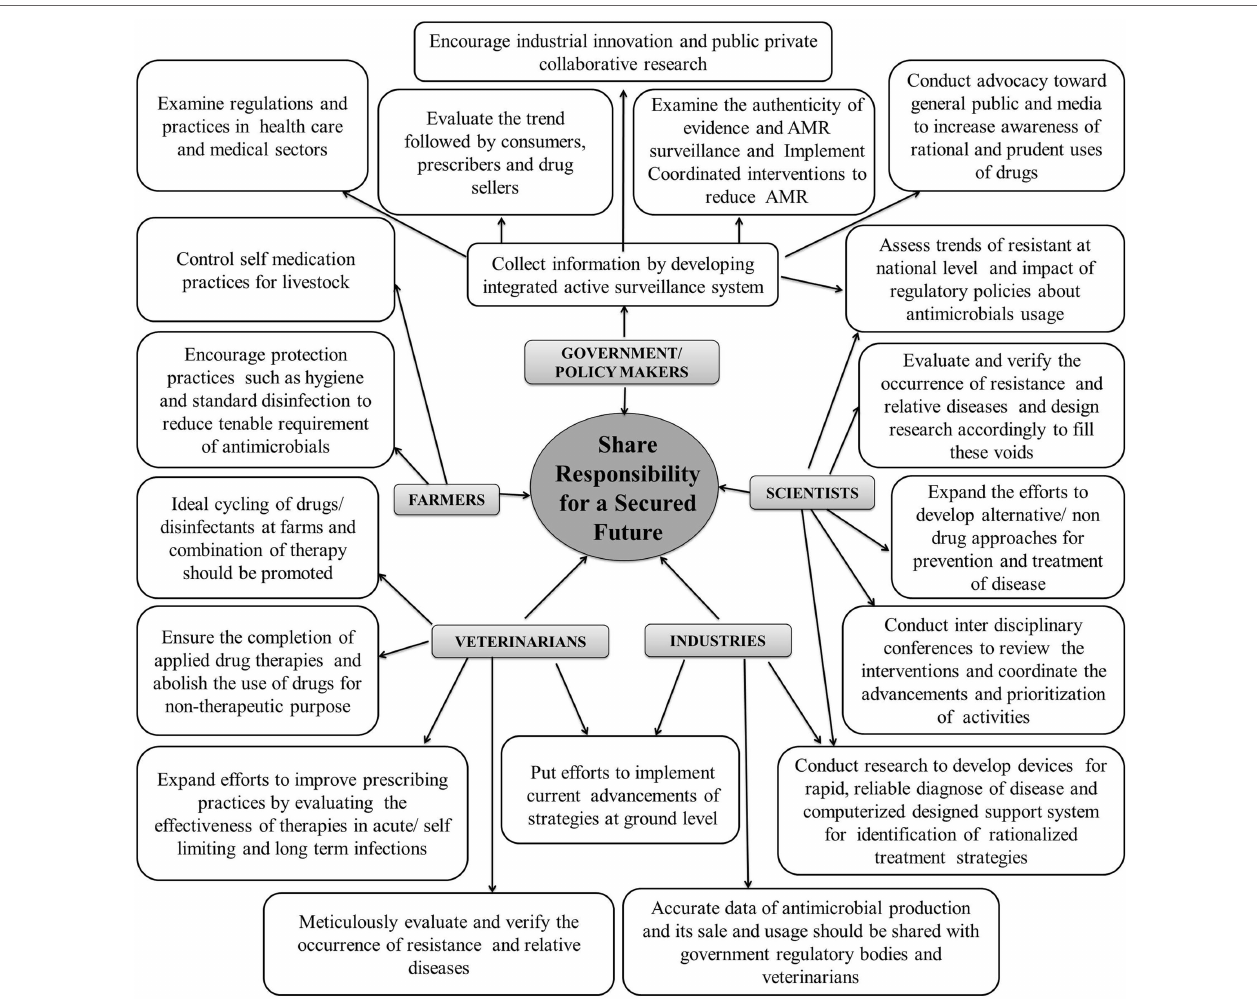
FiGURe 3 | Collaborative meticulous approaches to mitigate antimicrobial resistance